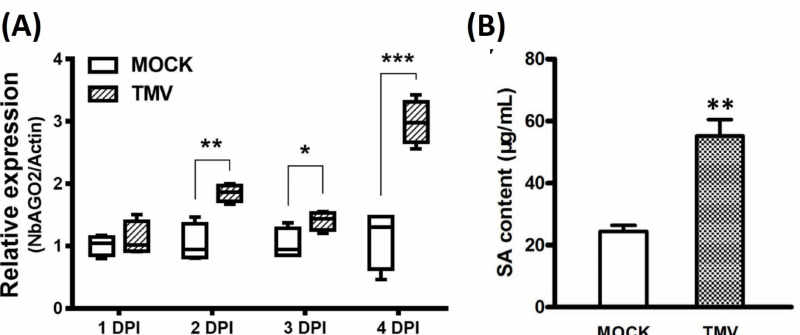
Figure 5. TMV infection elevated NbAGO2 expression and endogenous SA level. ( A ) Three-leaf stage N. benthamiana was infected with TMV, and the leaves were collected at di ff erent DPI. NbAGO2 expression was determined by quantitative real-time PCR. Plants inoculated with inoculation bu ff er containing empty vector expression GV3101 served as control treatment. NbAGO2 expression in control was arbitrarily designated as 1. NbActin gene served as the internal control. ( B ) Three-leaf stage N. benthamiana was infected with TMV, and the leaves were collected 5 h post infection. SA level was determined by UV Vis Spectrophotometry at 310 nm. Significant di ff erences between mock and infected groups were calculated by Student’s t -test. Single, double, and three asterisks indicated significant di ff erence at p < 0.05, p < 0.01, and p < 0.001,